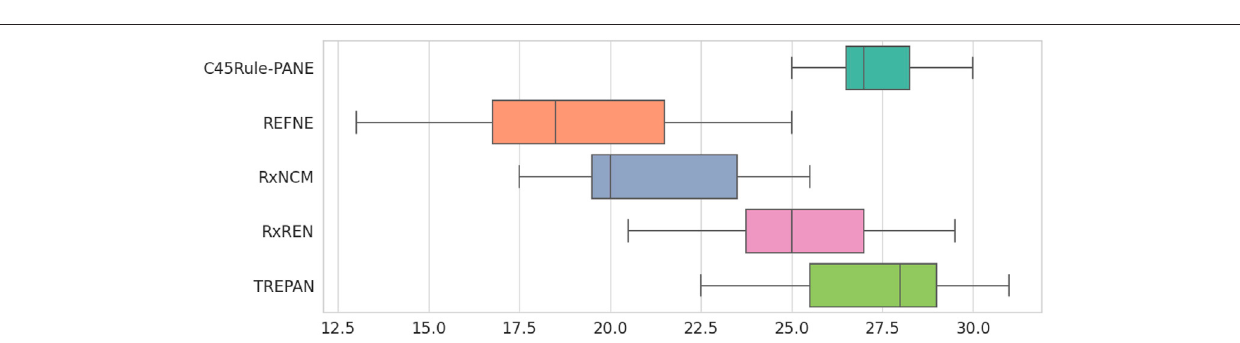
FIGURE 12 | Distribution of the total ranks of the fi ve rule-extraction methods across datasets and metrics.